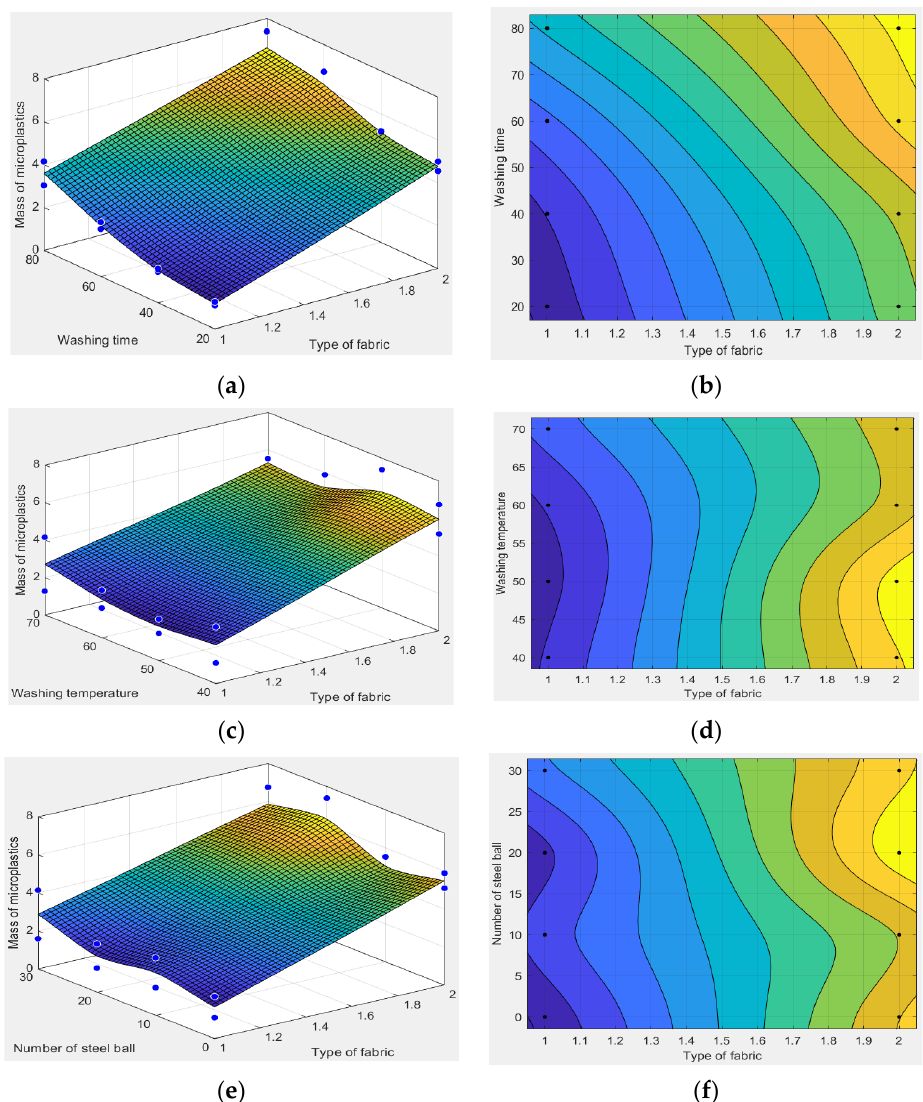
Figure 6. ( a ) Three-dimensional surface diagram of fabric type and washing time; ( b ) contour plot of fabric type and washing time; ( c ) three-dimensional surface diagram of fabric type and washing temperature; ( d ) contour plot of fabric type and washing temperature; ( e ) three-dimensional surface diagram of fabric type and steel ball count; ( f ) contour plot of fabric type and steel ball count. (The blue dots and black dots in the figure represent the positions of the values of the 16 experimental points respectively).